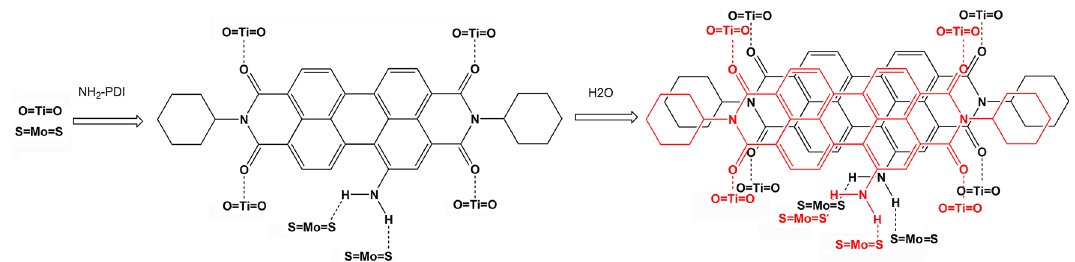
Figure 4. Graphical representation of the investigated adsorption mode of NH 2 -PDI onto the TiO 2 and MoS 2